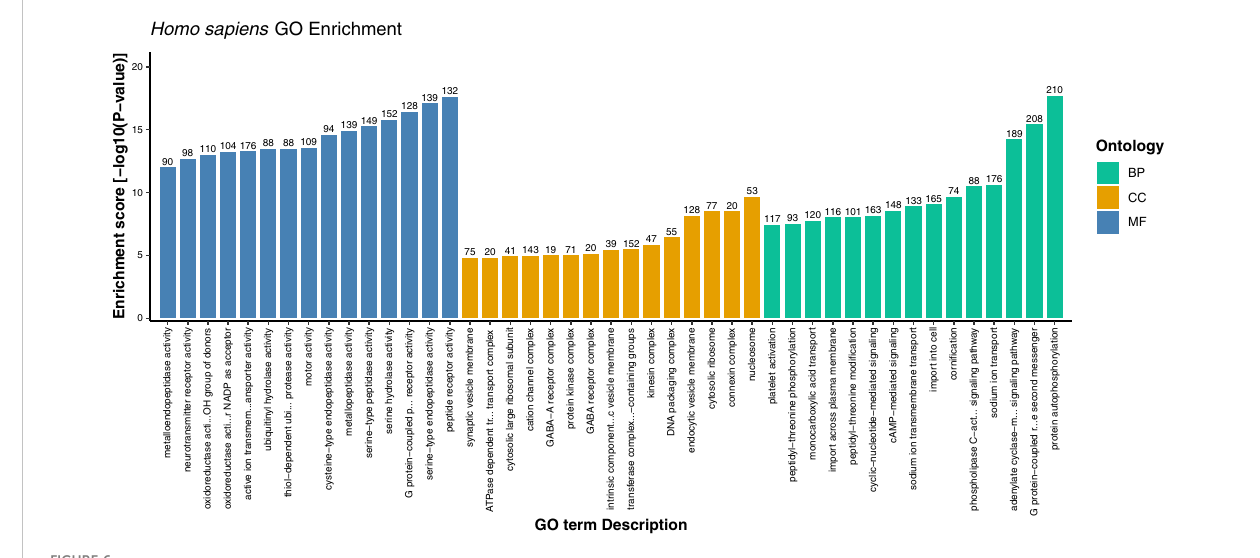
FIGURE 6 Gene ontology enrichment of host proteins representing top 15 terms from each category i.e., biological process, cellular component, and molecular function on the basis of enrichment score.